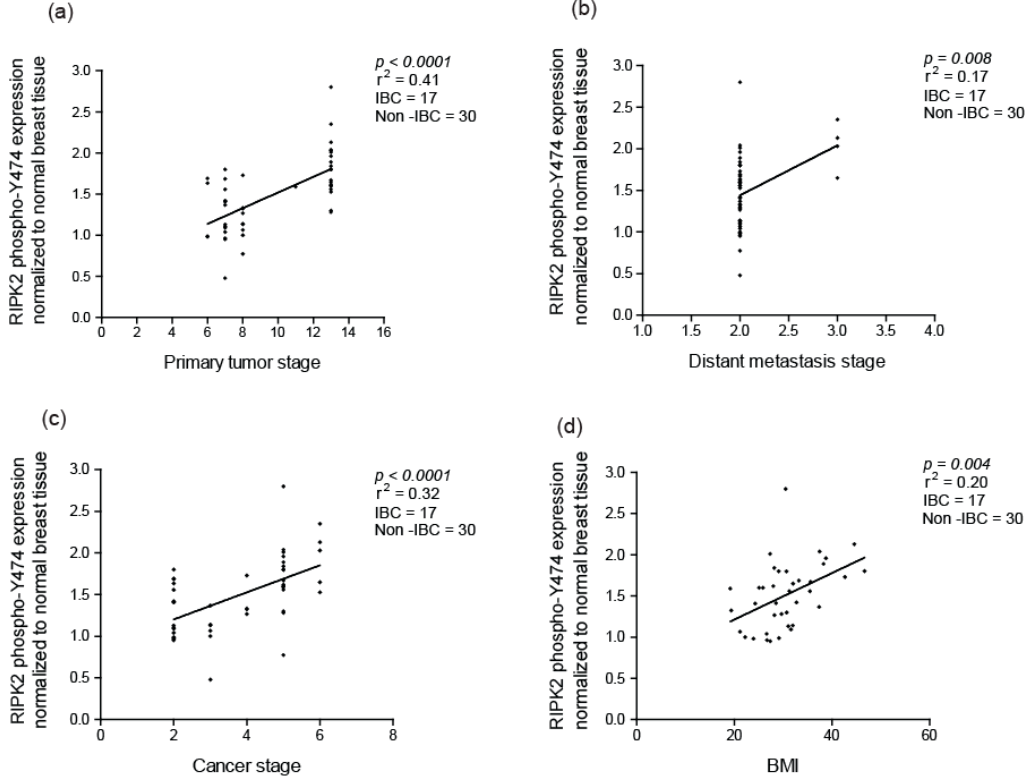
Figure 5. Correlation of active RIPK2 expression with: ( a ) primary tumor stage; ( b ) presence of distant metastasis stage; ( c ) cancer stage; and ( d ) body mass index (BMI) in breast cancer. Active RIPK2 denotes autophosphorylation at site Y474.